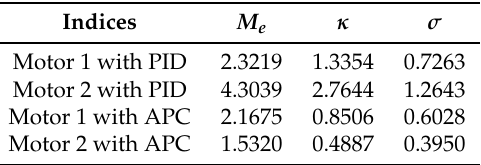
Table 2. Performance